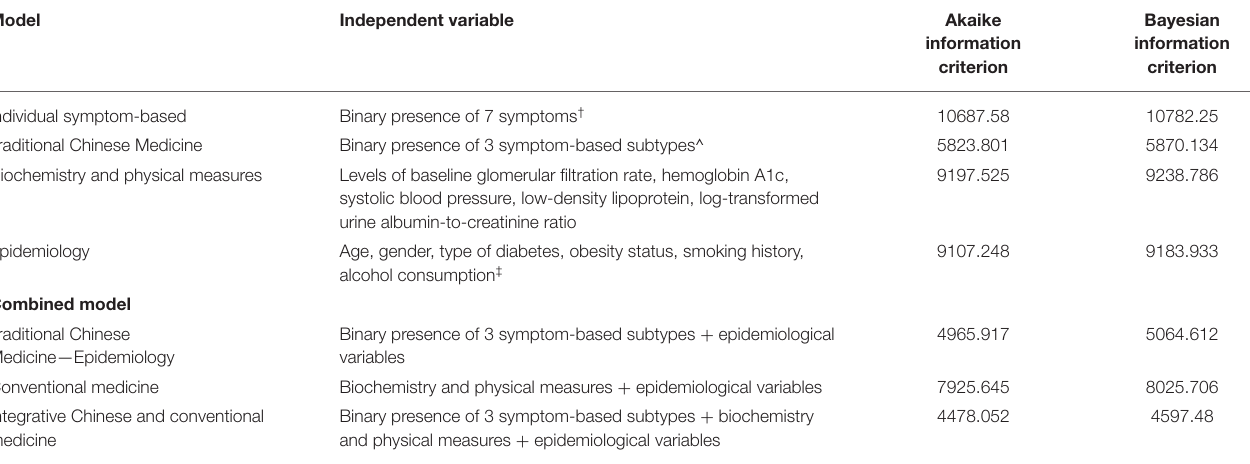
TABLE 1 | Performance of regression models on longitudinal measurements of glomerular filtration